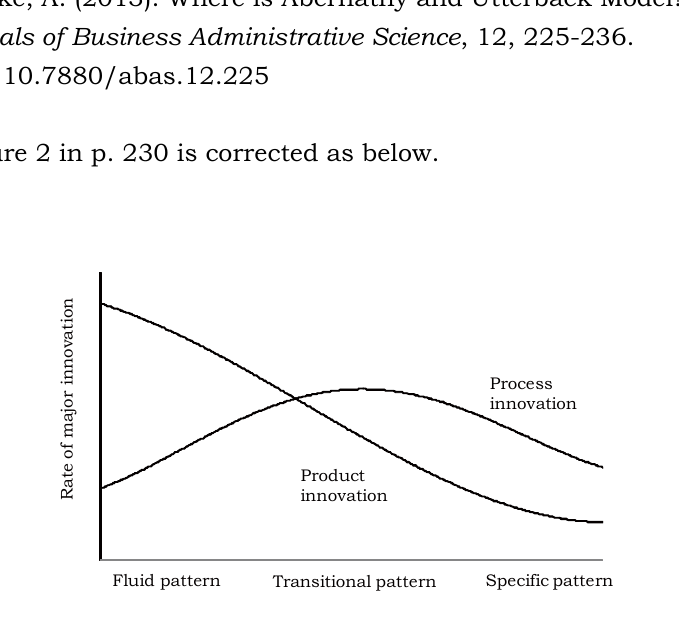
Figure 2. A-U model in Abernathy and Utterback (1978) From “Patterns of industrial innovation,” by W. J. Abernathy and J. M. Utterback, 1978, Technology Review , 80 (7), p. 40. Copyright 1978. Reprinted by permission conveyed through Copyright Clearance Center,